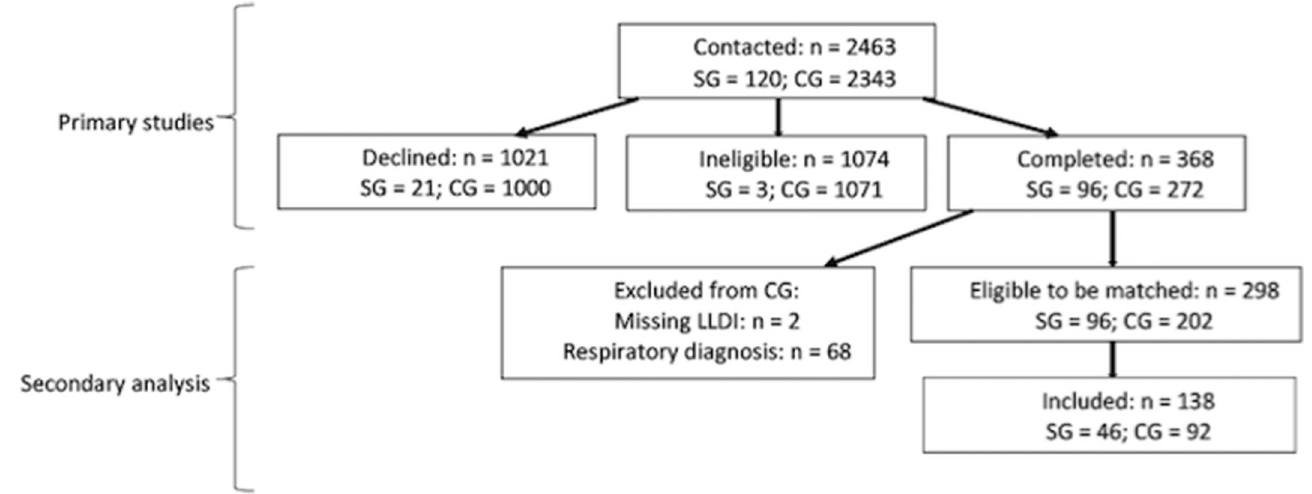
Fig 1. Flow diagram of recruitment for primary studies and inclusion in current analysis. SG = study group; CG = control group.